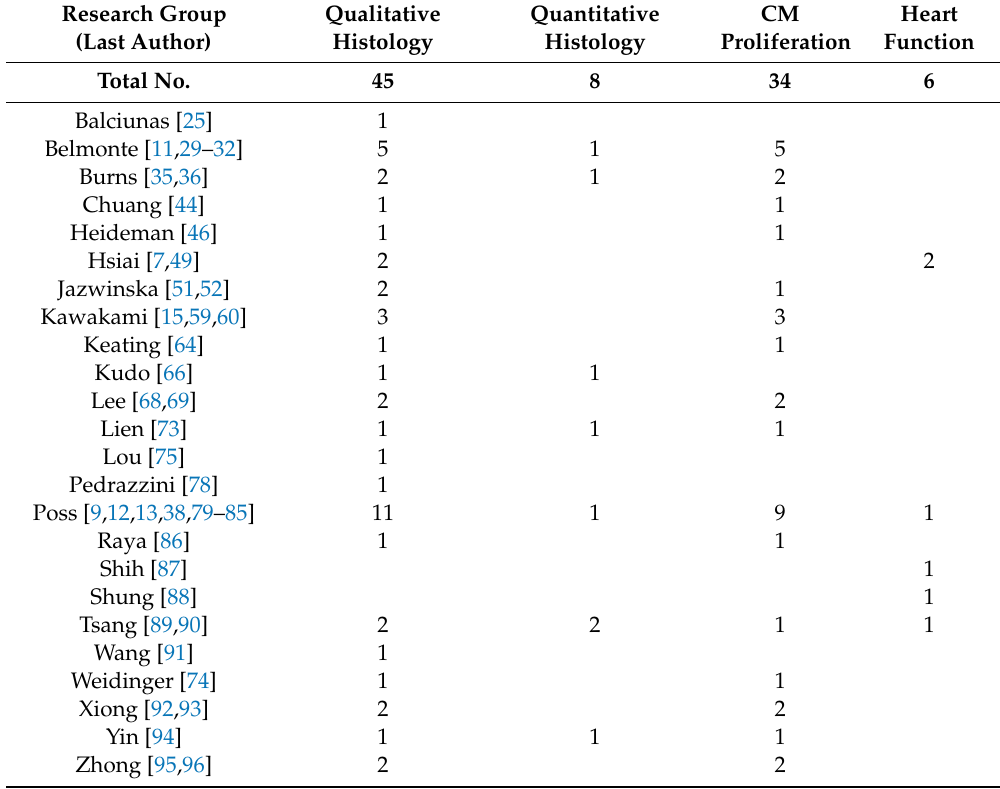
Table2. Methodsusedtoevaluateheartregrowthandregenerationafterapexresection(AR)inzebrafish. Research